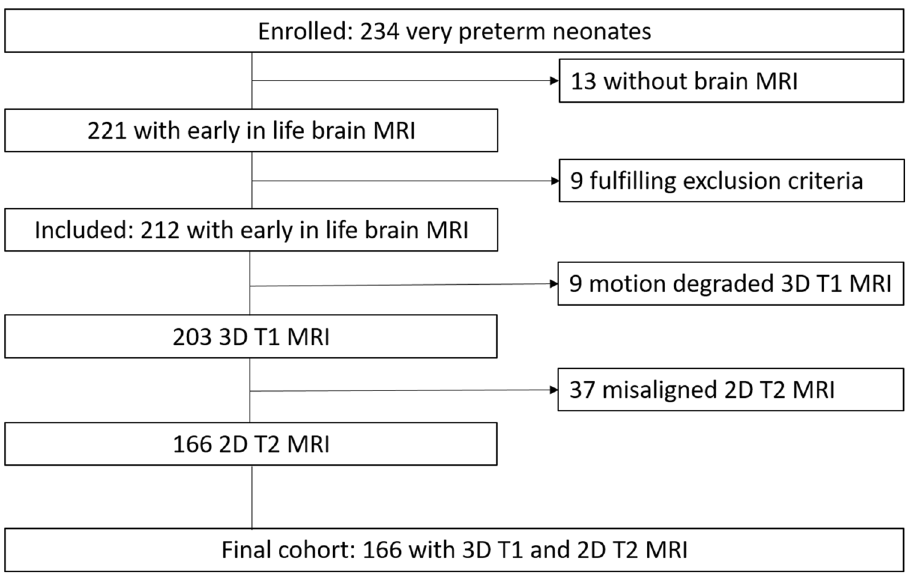
Figure 1. Patient and MRI sequence